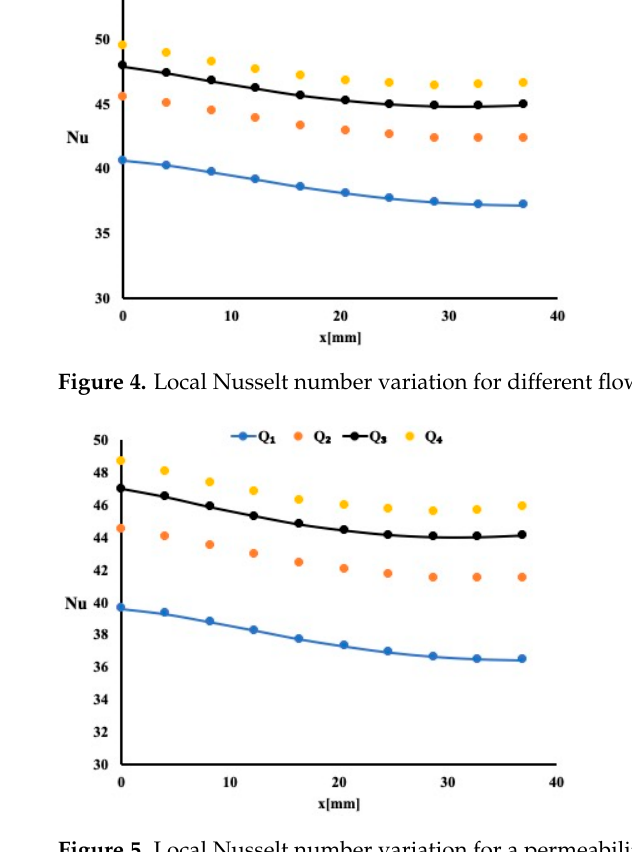
Figure 5. Local Nusselt number variation for a permeability of 20 PPI.